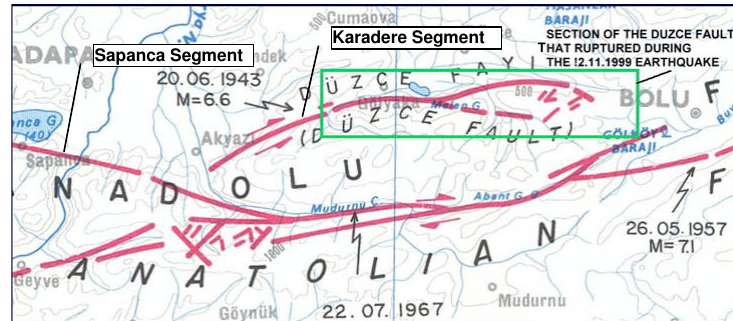
rectangular, (KOERI, 2000) 44